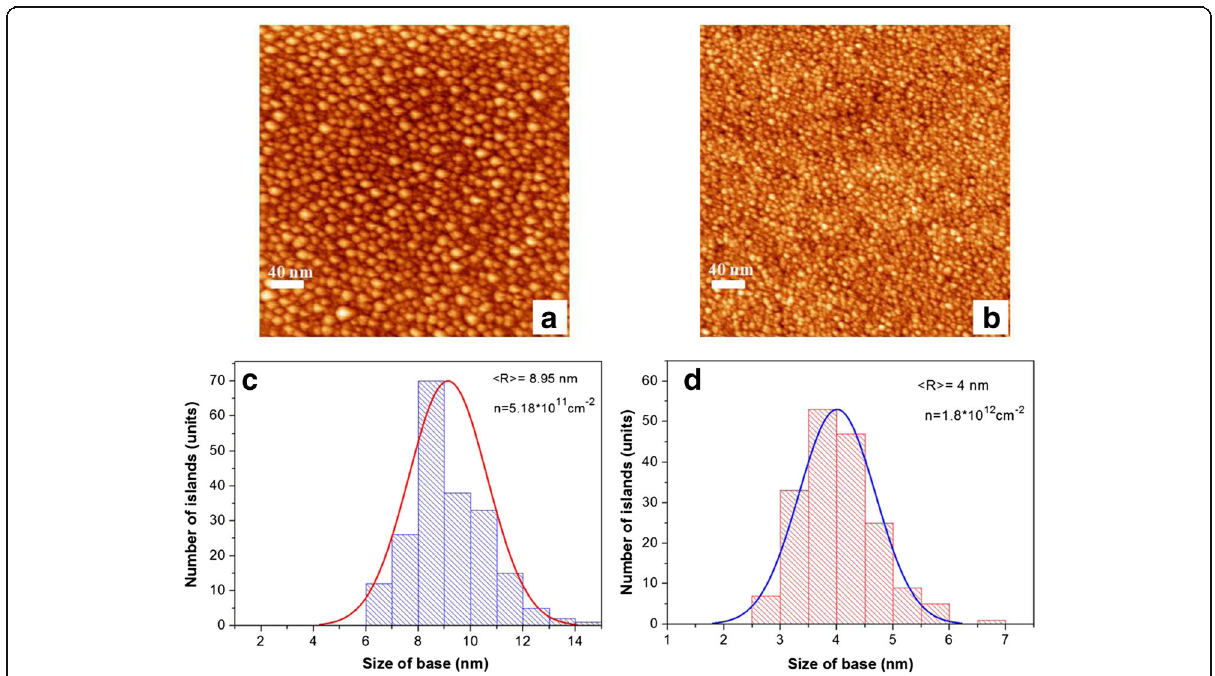
Fig. 5 STM images of the Ge 0.75 Si 0.2 Sn 0.05 surface with the scan size of 400 nm×400 nm: a the Ge 0.75 Si 0.2 Sn 0.05 surface in the first period, b the Ge 0.75 Si 0.2 Sn 0.05 surface in the fifth period; the distribution histograms for the number of islands on the size of the base for the Ge 0.75 Si 0.2 Sn 0.05 film: c in the first period (the Ge 0.75 Si 0.2 Sn 0.05 film thickness equals 1.78 nm) and d in the fifth period (the Ge 0.75 Si 0.2 Sn 0.05 film thickness equals 1.89